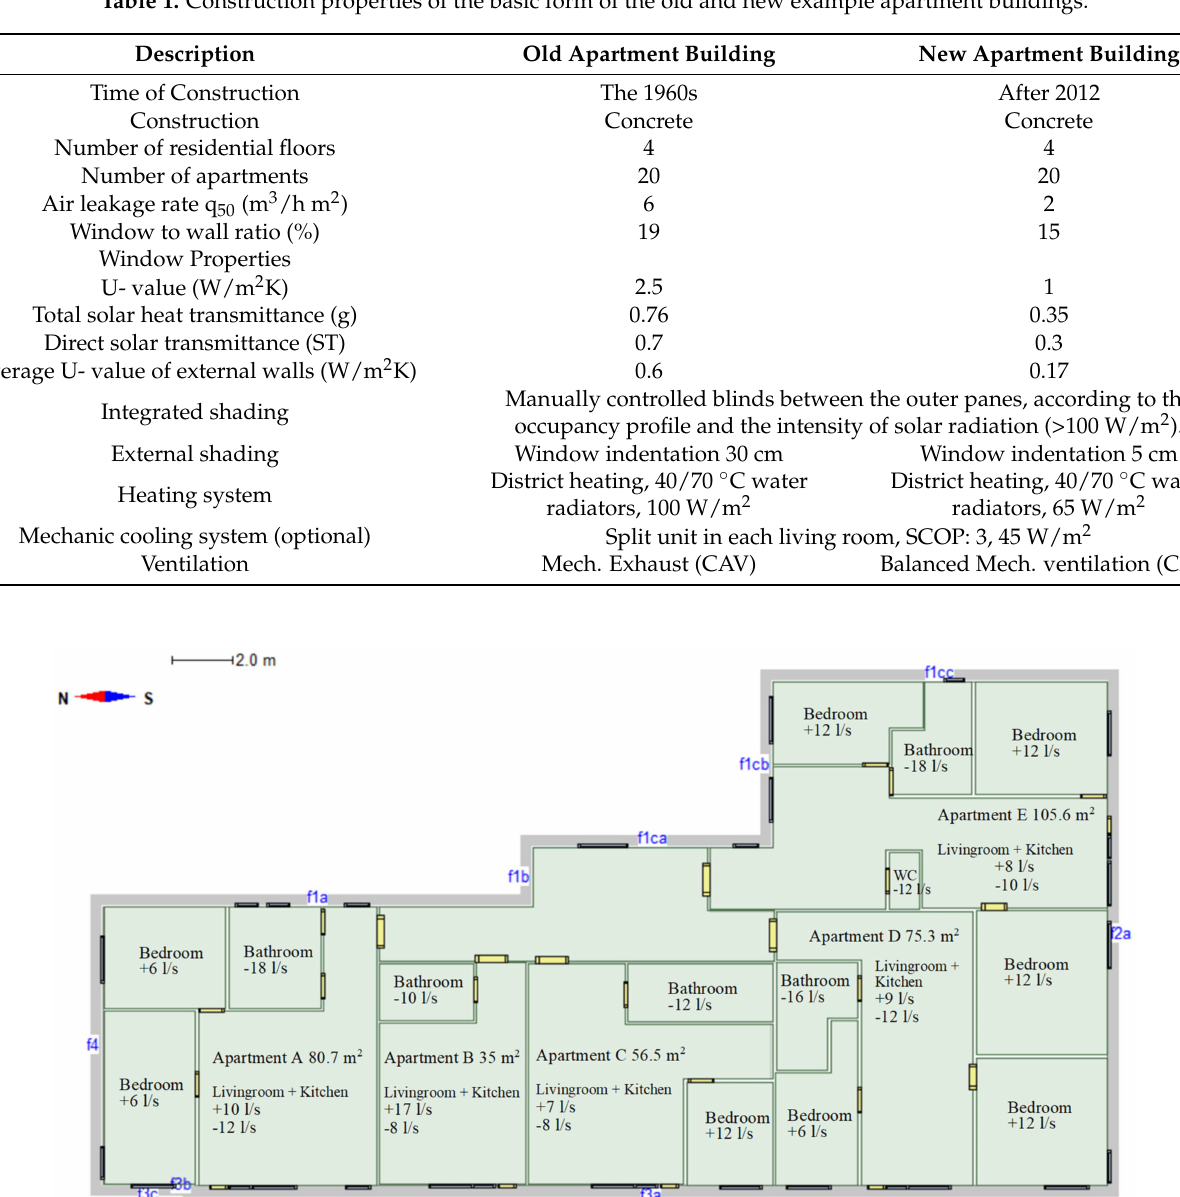
Figure 3. Floor plan and room types in the old and new apartment building, the exhaust airflow rates of the old building, and the air flow rates of the new